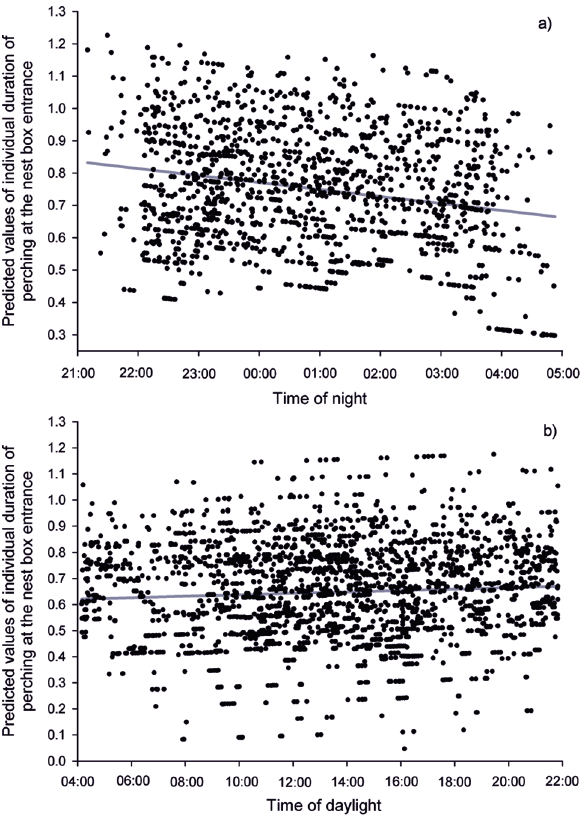
Figure 3. Predicted values of the log-transformed individual duration of nestlings’ perching at the nest box entrance during a) night, and b) daylight plotted against the time of night and day, respectively.